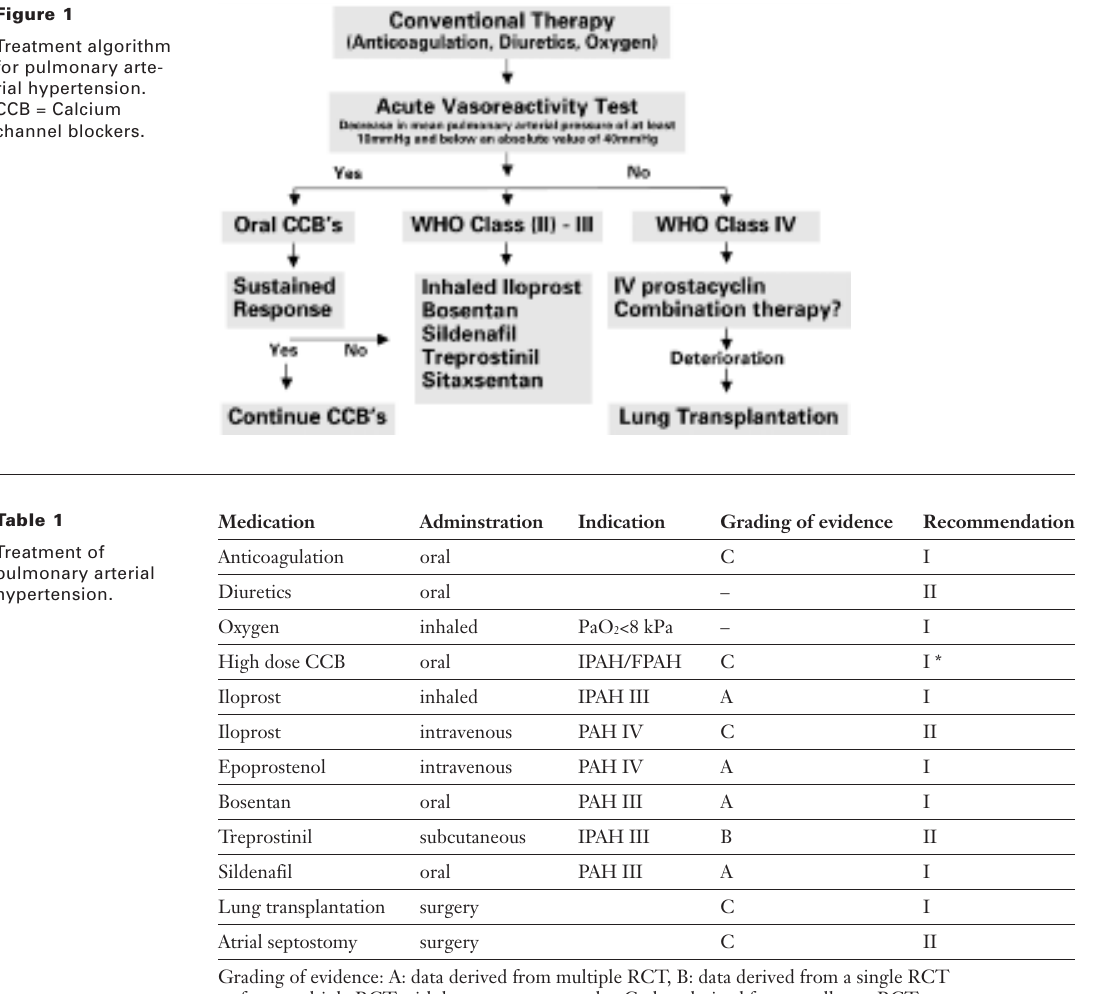
Figure 1 Treatment algorithm for pulmonary arte- rial hypertension. CCB = Calcium channel blockers.